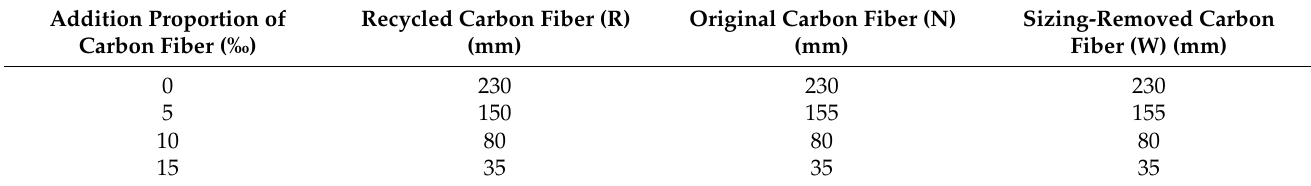
Table 5. The slump of ECFRC under different fiber weight